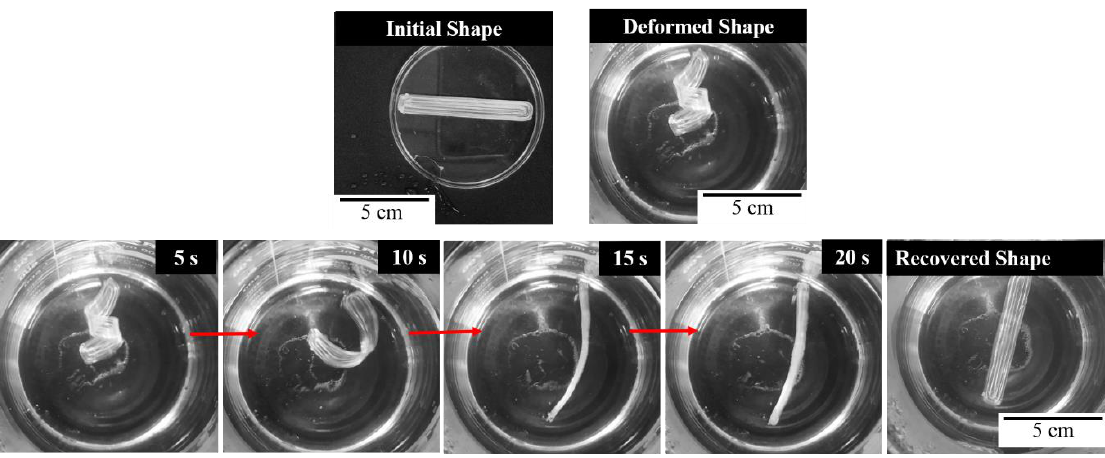
Figure 5. DSC Heat flow thermogram of the second heating and cooling cycle of the virgin pellet, and printed Diaplex 9020 sample.